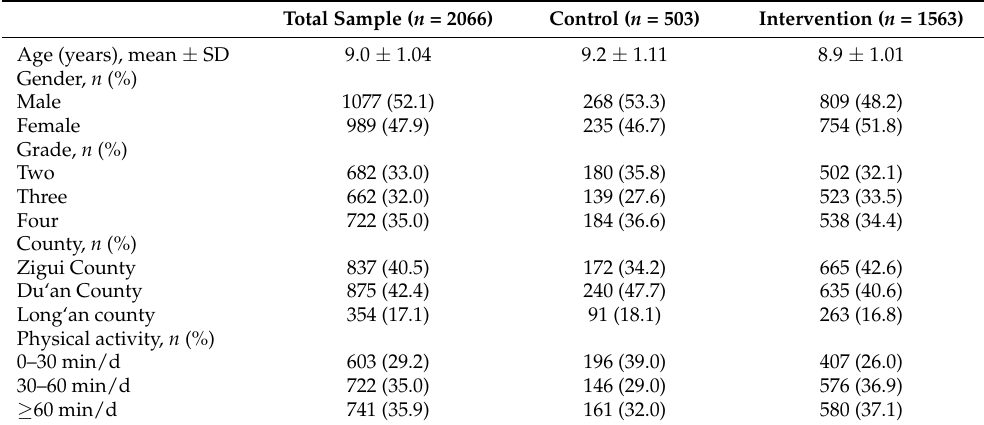
Table 2. Comparison of characteristics of children from the intervention group and control group at